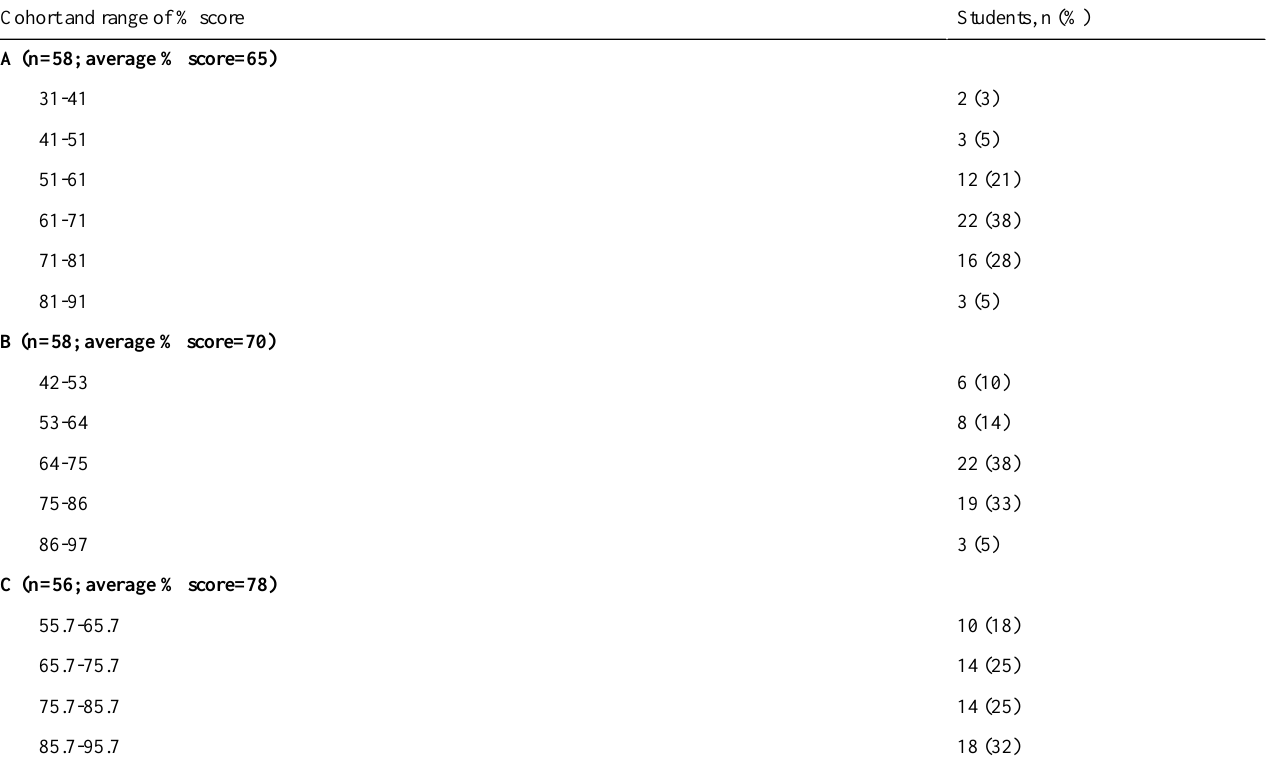
Students, n (%)Cohort and range of % score